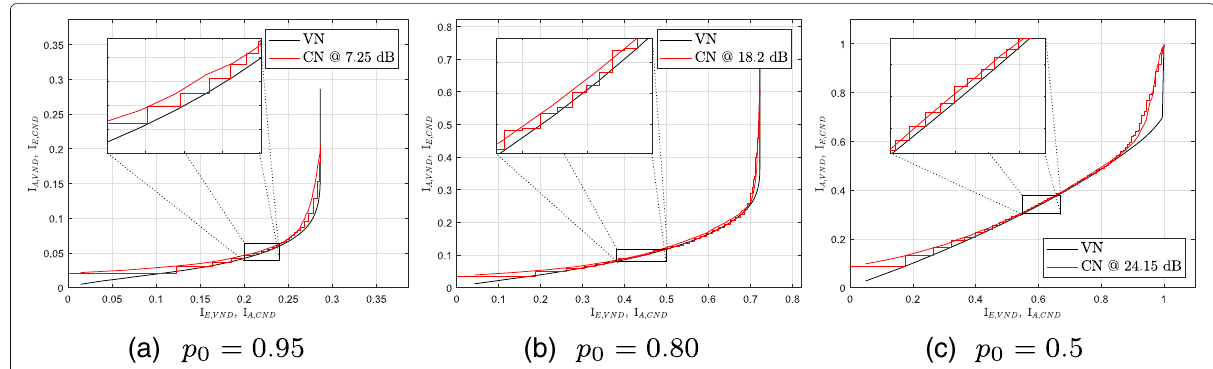
Fig. 8 EXIT chart and real trajectories of the designed codes for AWGN channels and sources with c p 0 = 0.5, b p 0 = 0.8, and a p 0 = 0.95